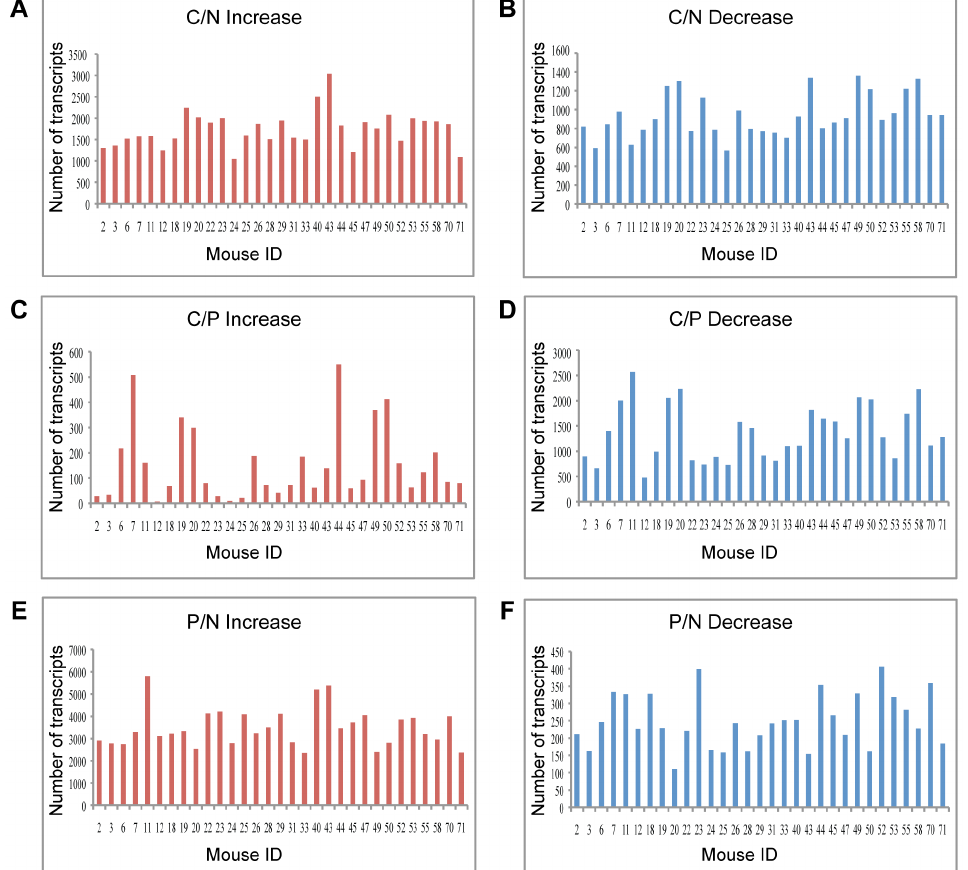
Figure 1. Analysis of individual mice reveals diversity in transcript number that changed during carcinogenesis. The number of transcripts that were up-regulated (left panel) or down-regulated (right panel) at least 4-fold in each mouse during the transition from: A. normal skin to carcinoma (C/N); B. papilloma to carcinoma (C/P); and C. normal skin to papilloma (P/N). Mouse IDs refer to the IDs in the original data [17].